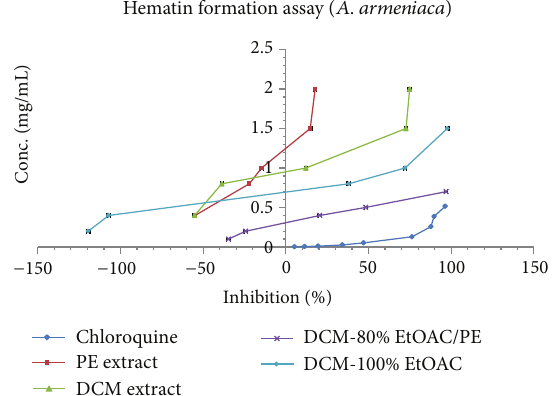
Figure 2: Comparison of % inhibition of heme crystallization between active extracts and fractions of A. armeniaca and chloro- quine solution in 𝛽 -hematin formation assay. The values were reported as Mean ±